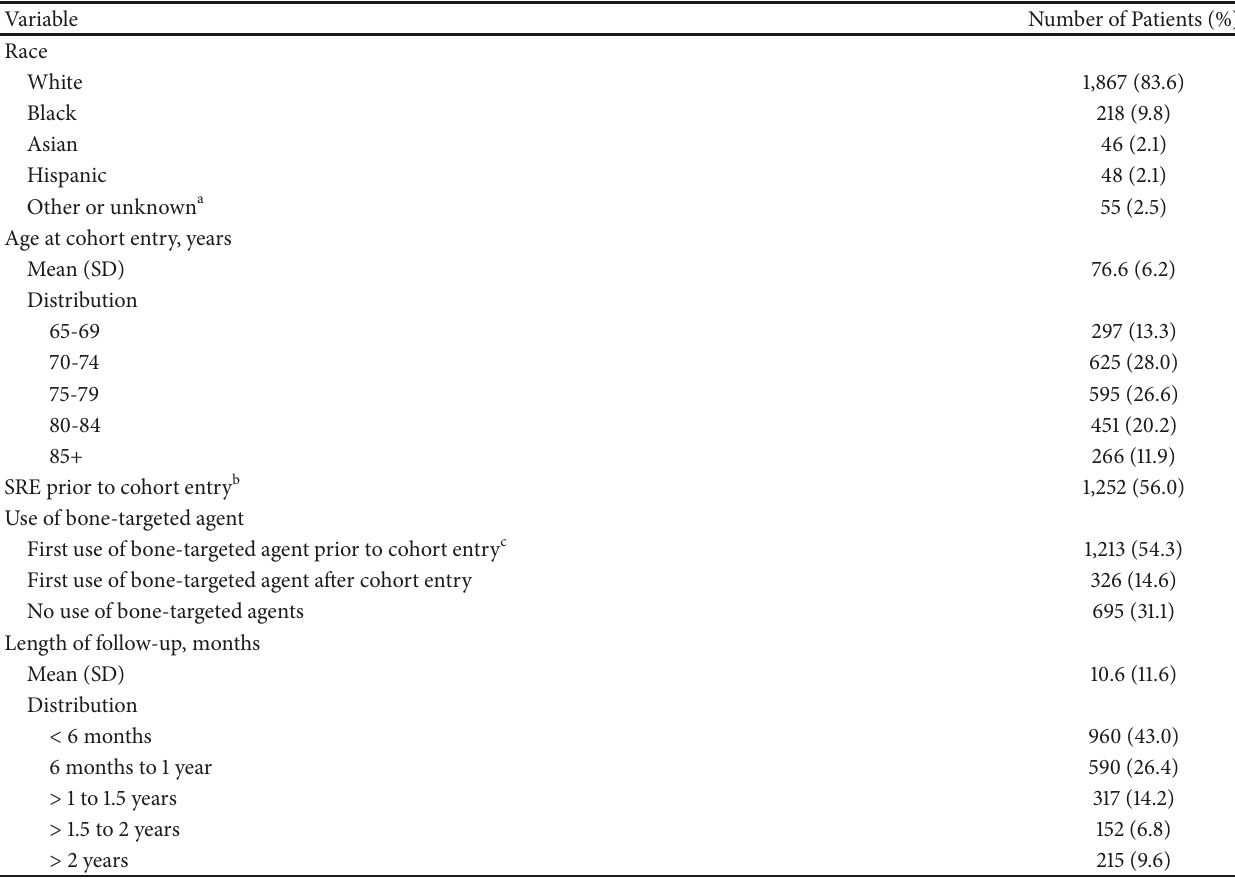
Table 1: Demographic and clinical characteristics of the study cohort (N =